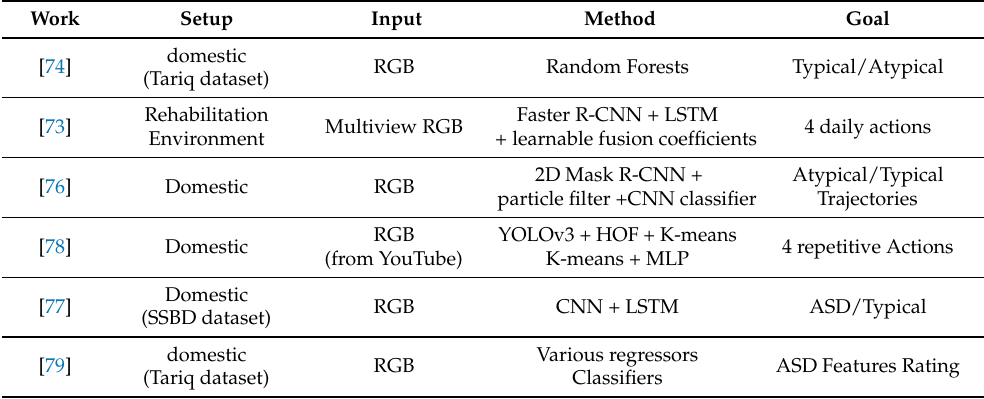
Figure 6. The innovative tool proposed in [78]. It follows a Bag-of-Visual-Words configuration for recognising 4 repetitive actions that are a potential indication of ASD disorder. Table 4. Summarization of works dealing with movements assessment in